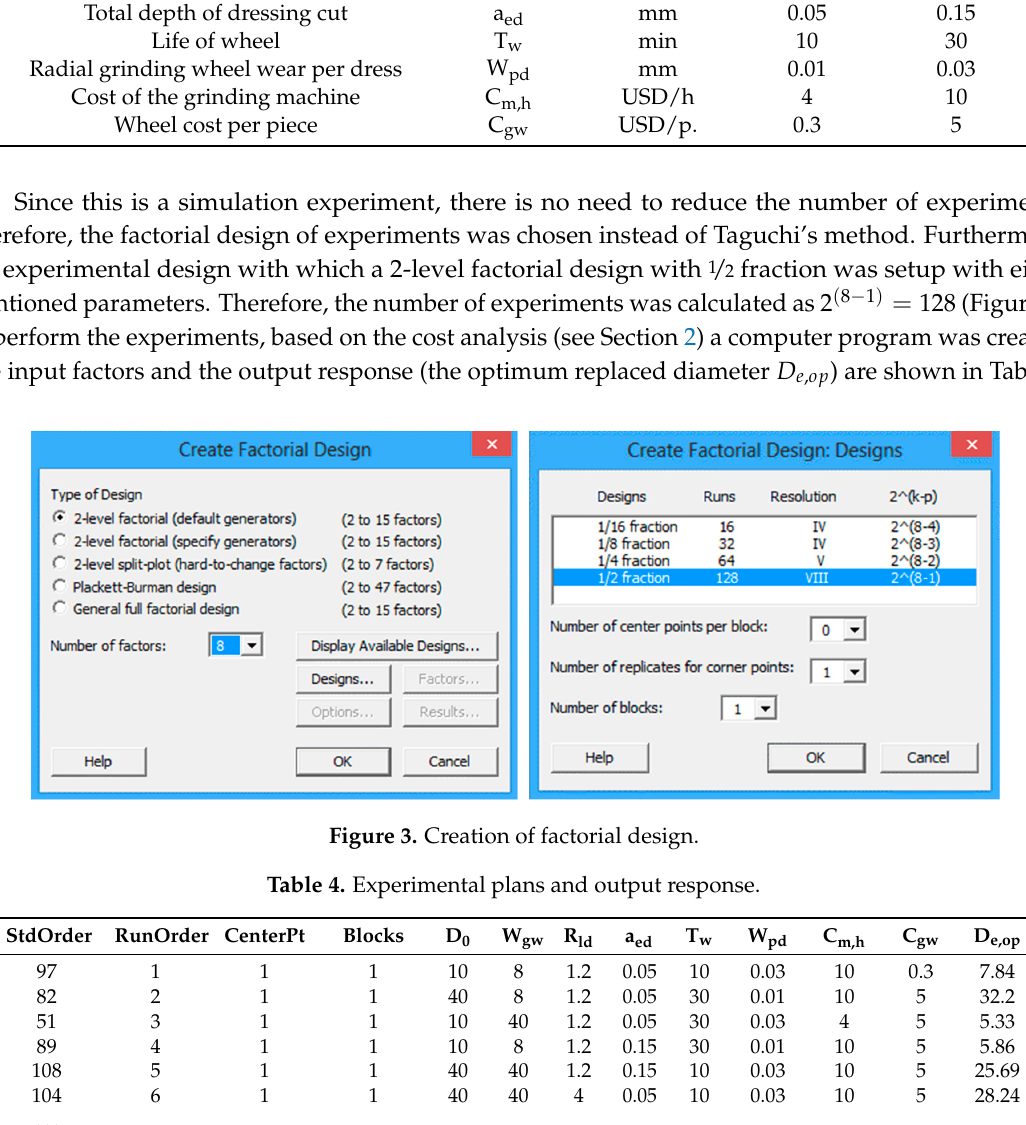
Table 3. Experimental input factors.